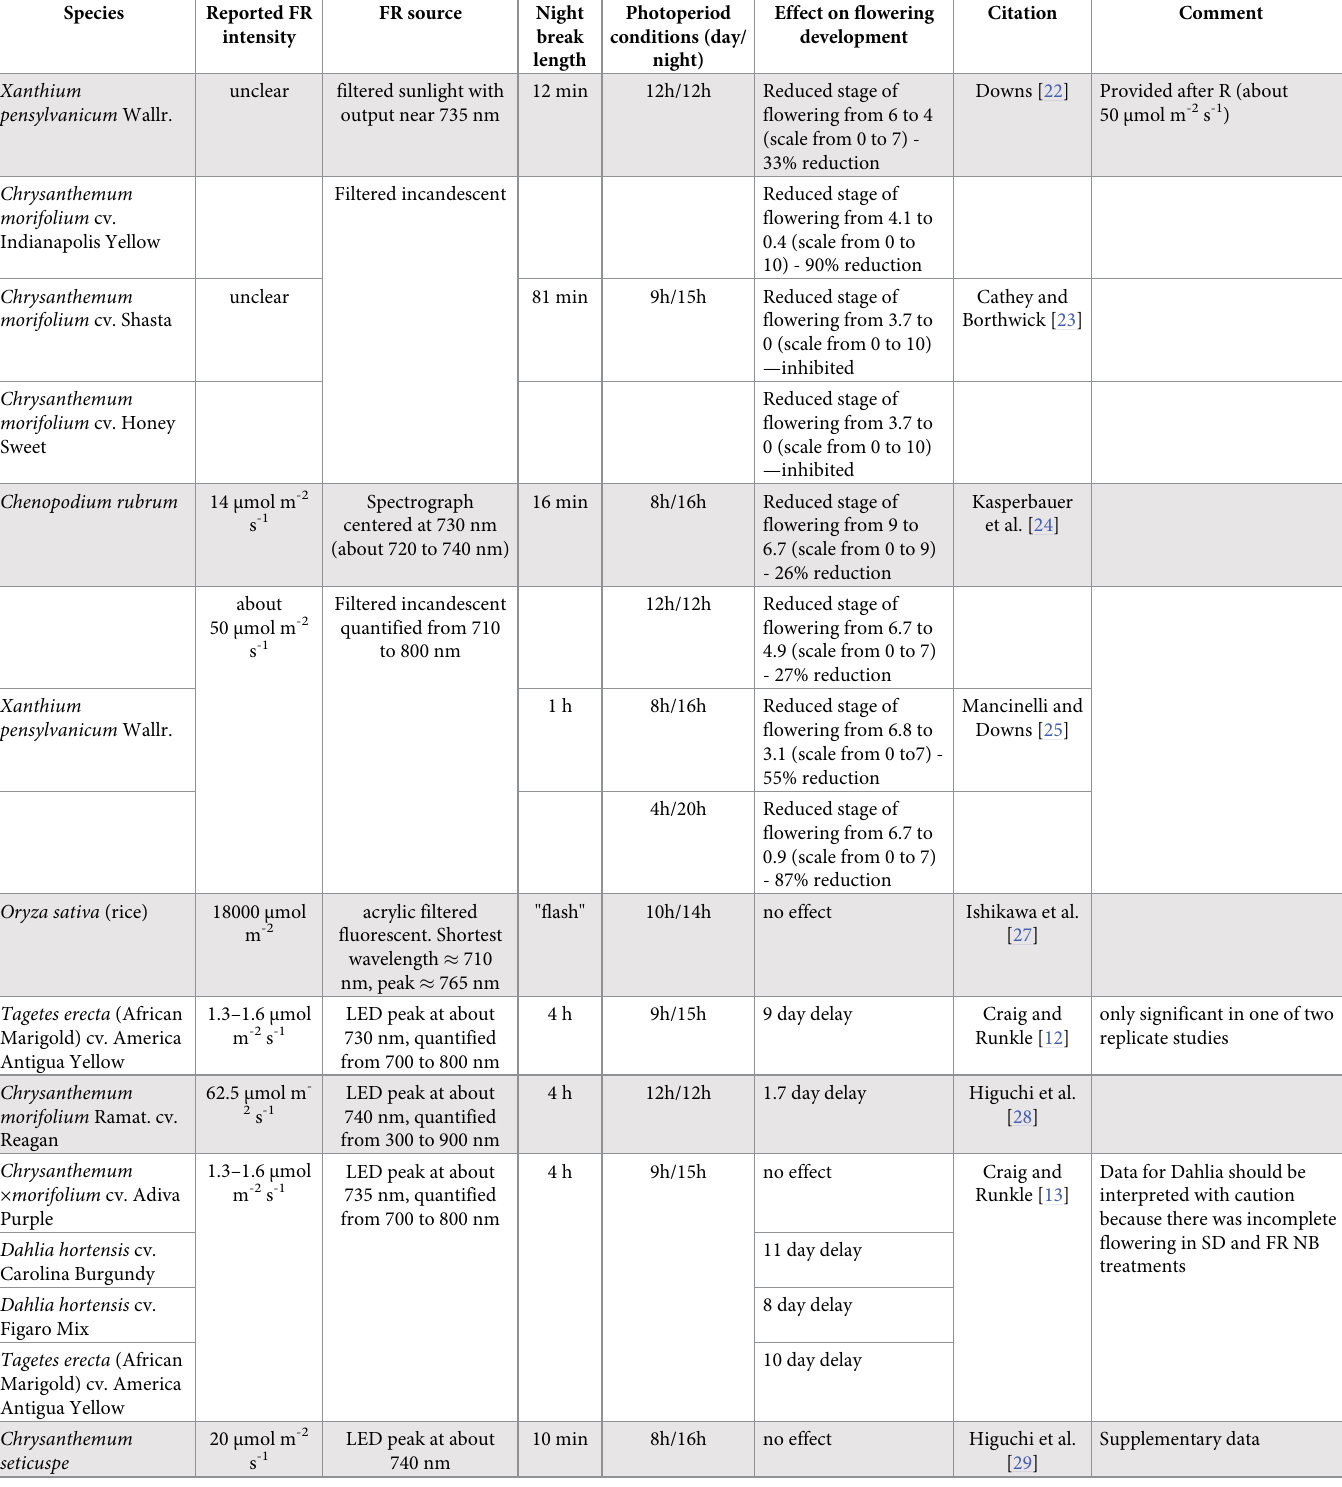
Table 1. Summary of the effect of far-red night-break lighting on flowering development or time to flowering.